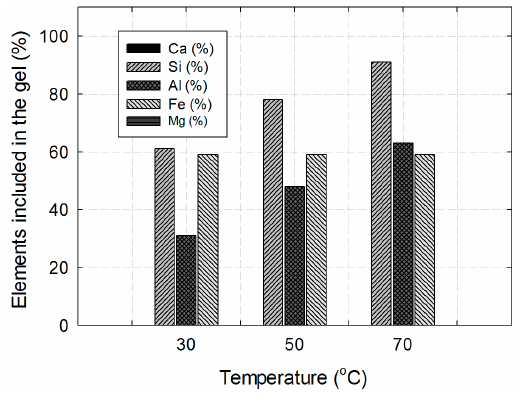
Figure 8. Relative amounts of elements included in the gel.